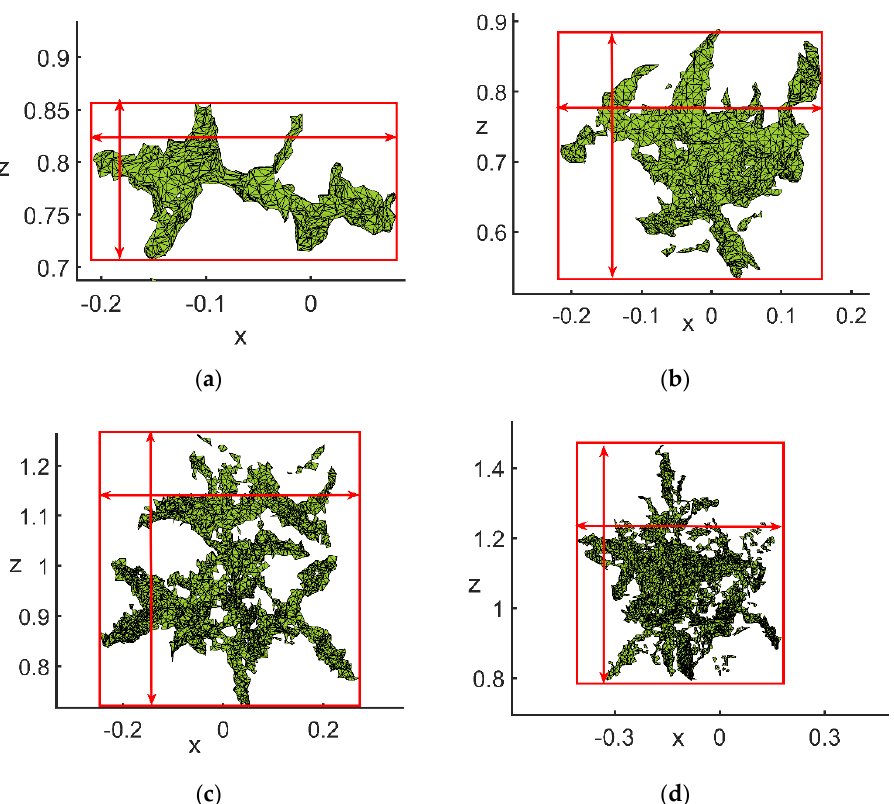
Figure 22. Schematic ofthe calculation ofcrown width: ( a ) flowering stage; ( b ) podding stage; ( c ) filling stage; ( d ) mature stage. ( c ) filling stage; ( d ) mature